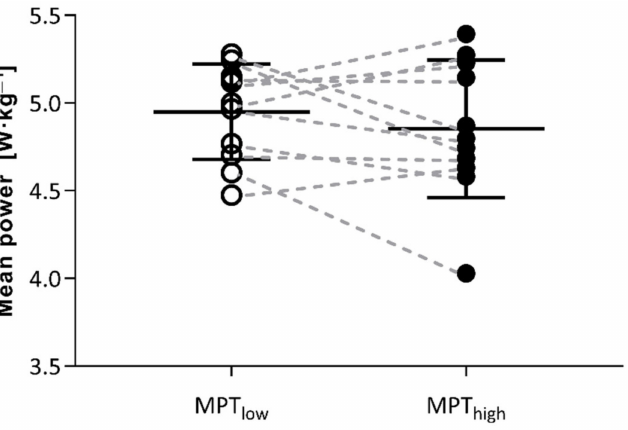
Figure 2. MPT performance (power output) in final spurt of MPT low and MPT high